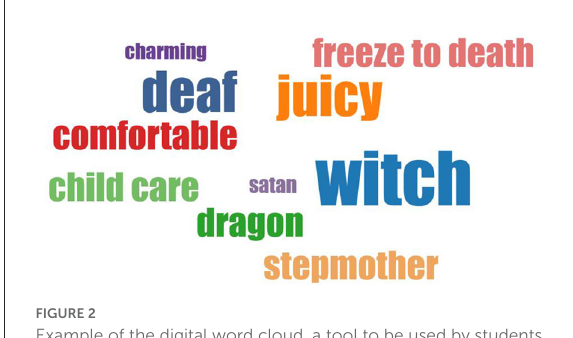
FIGURE2 Example of the digital word cloud, a tool to be used by students to collect and visualise unknown words in the script that they find. Word size corresponds to the number of students that marked a word as “unknown”.